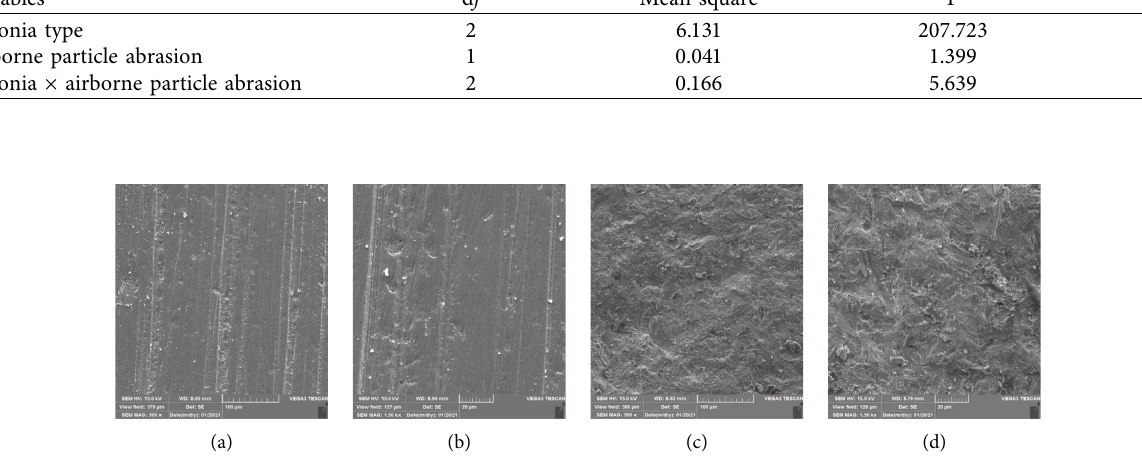
Figure 3: Multilayered zirconia SEM micrographs: (a, b) without APA and (c, d) with APA ( × 500 and × 1500 magnifications).